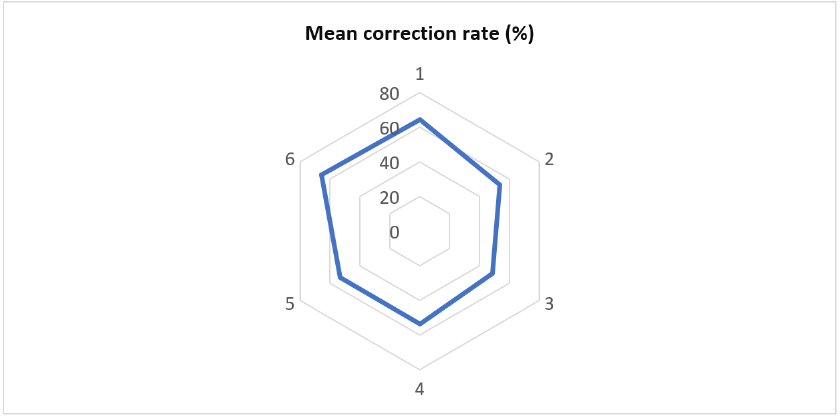
Figure 2. The average percentage of correction compared to different groups of Lenke’s classification.